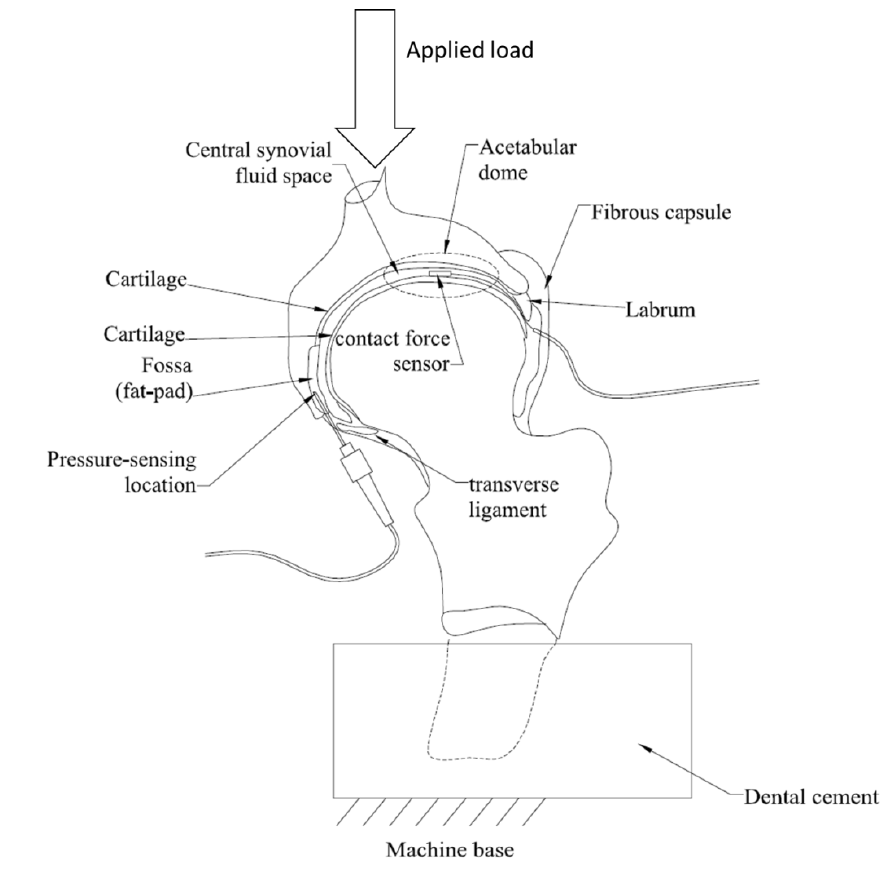
Figure 6. Schematic drawing of the cross-section of hip joint showing the insertion of the pressure and contact stress sensors into their optimal sensing locations. The hip stem was embedded in dental cement for fixation purposes during applying vertical loads